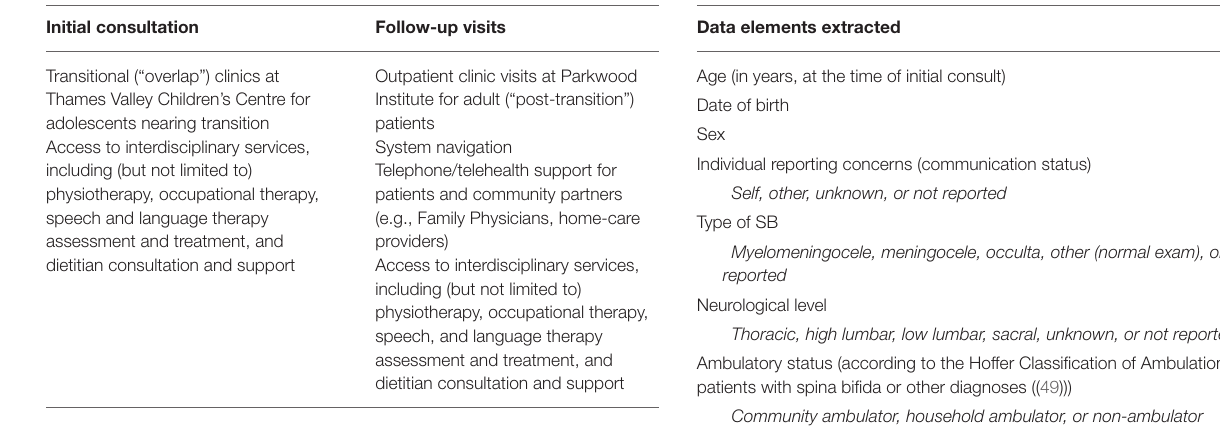
TABLE 1 | TLC services offered in initial consultation and follow-up visits. TABLE 2 | Patient factors and concerns